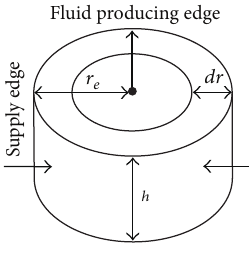
Figure 2: Radial flow unit